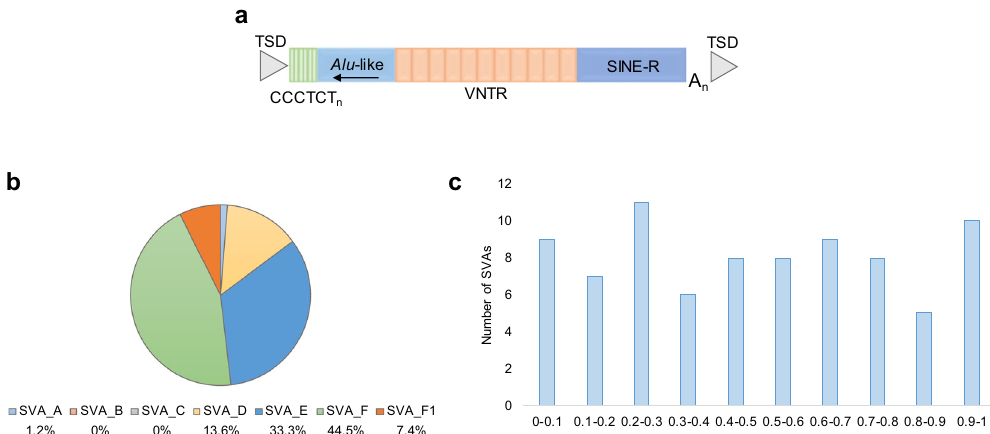
Fig. 1 Structure, subtype classi fi cation and frequency of polymorphic reference SVAs in the PPMI cohort. a The structure of a canonical SVA consists of a (CCCTCT) n hexamer repeat, an Alu -like region consisting of two antisense Alu fragments and an intervening unique sequence, a variable number tandem repeat (VNTR), a SINE-R domain and a poly A-tail. The length of an intact SVA can vary depending on the number of repeats present in the hexamer and VNTR domains. SVAs are fl anked by target site duplications (TSDs). b The proportion of the 81 reference SVA RIPs that belong to each of the seven subtypes of SVA. c The number of reference SVA RIPs that belong in each category of insertion allele frequency.